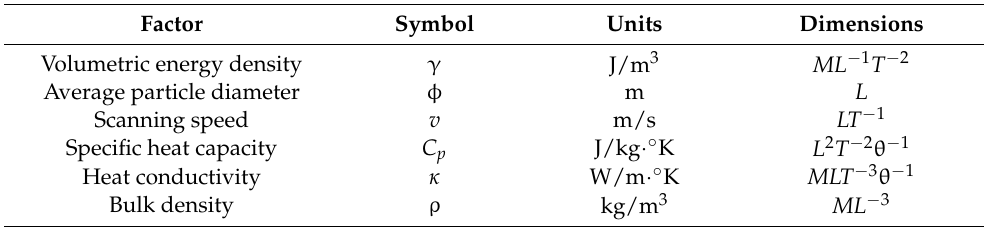
Table 4. Units, symbol, and dimensions of the physical quantities involved in the dimensional analysis of selective laser melting. Factor Symbol Units Dimensions Volumetric energy